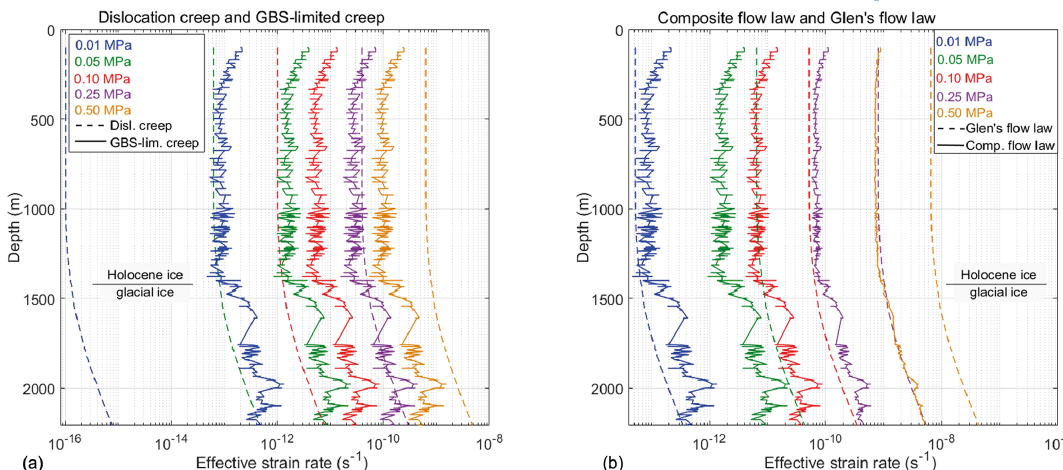
Figure 10. Stress sensitivity of the deformation mechanisms in the Holocene and Glacial ice. (a) Strain rates predicted by the dislocation creep mechanism (dotted lines) and GBS-limited creep (continuous lines) at different constant stress values. For readability, only the results of the microscale constant stress model are shown. (b) Plot of Glen’s flow law (dotted lines) and the composite flow law (continuous lines). For (a) and (b) the temperature profile and the grain size distribution of the NEEM ice core were used in combination with the flow law parameters in Table